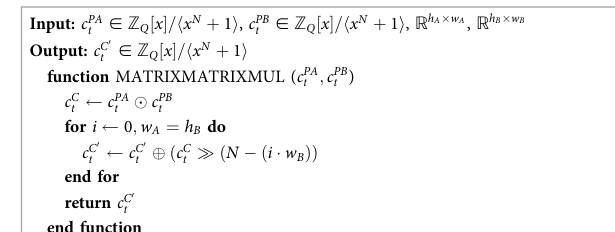
Algorithm 8 Matrix-Matrix Multiplication